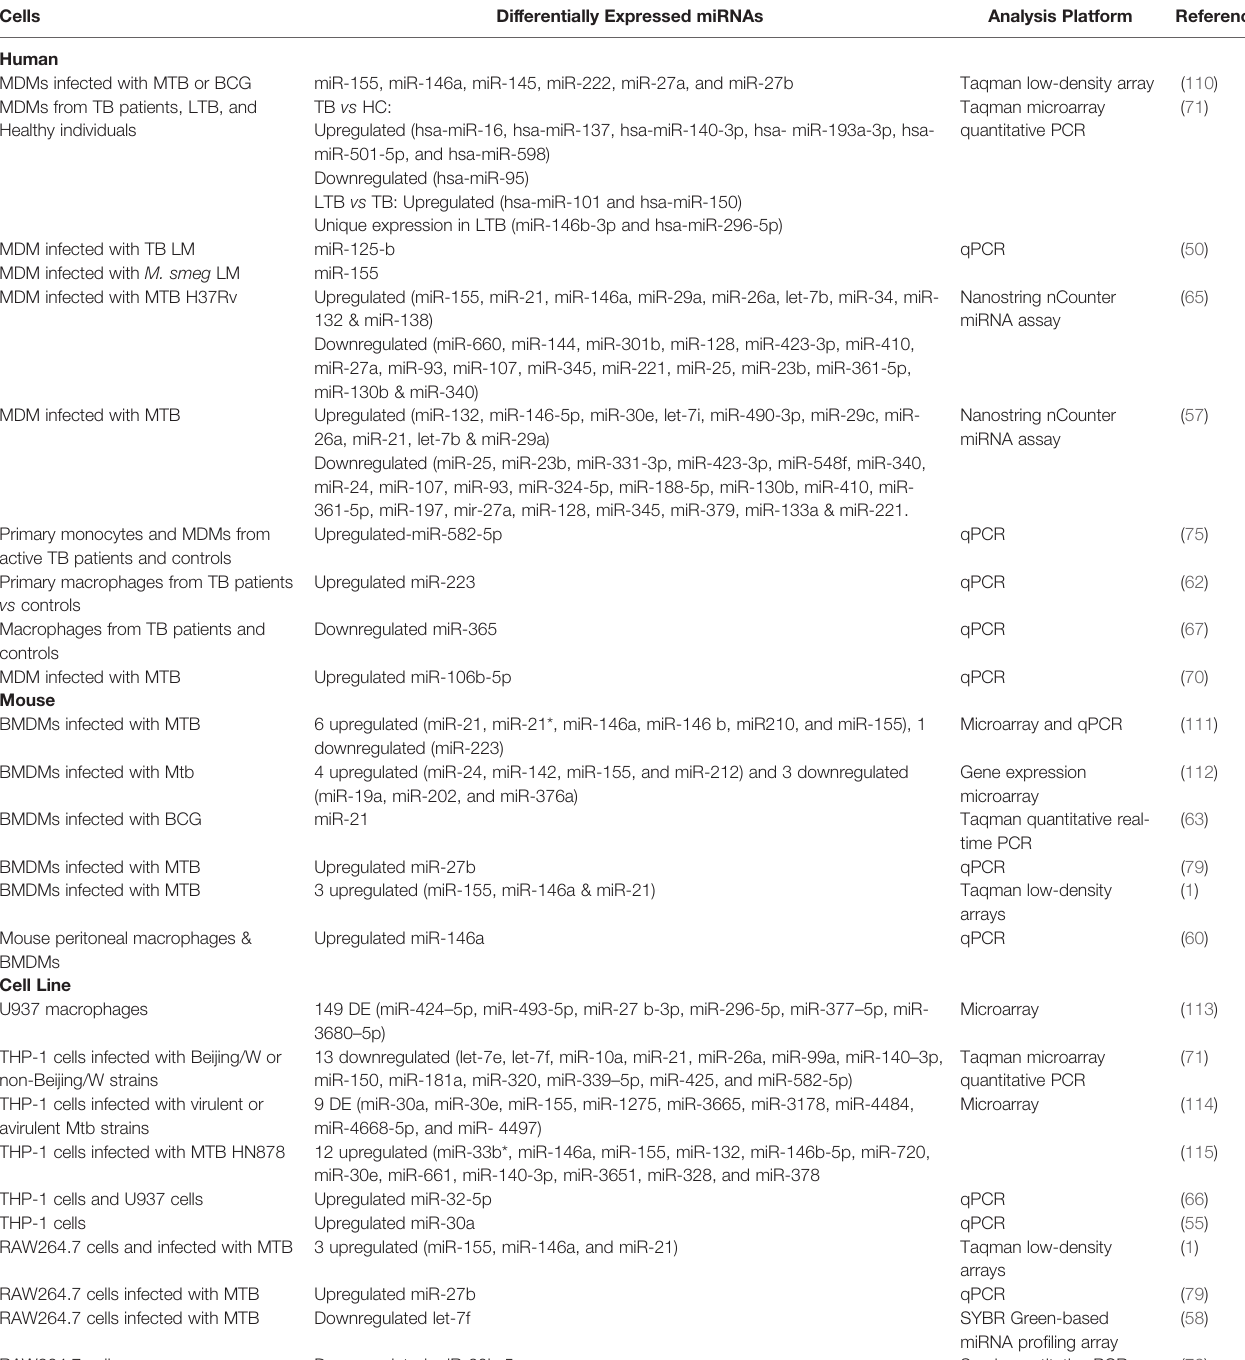
TABLE 1 | Monocyte/macrophage-based miRNAs as biomarker candidates for TB.